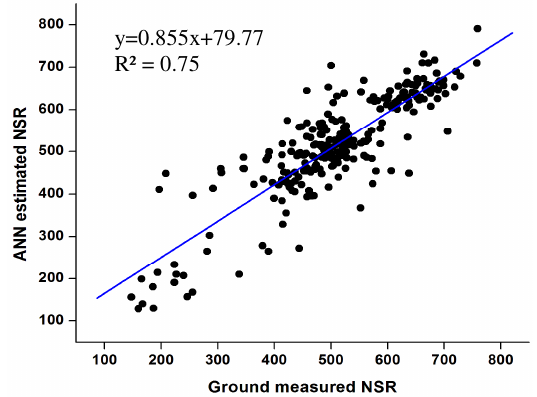
Figure 4: scatter between tower measurements with ANN derived NSR.